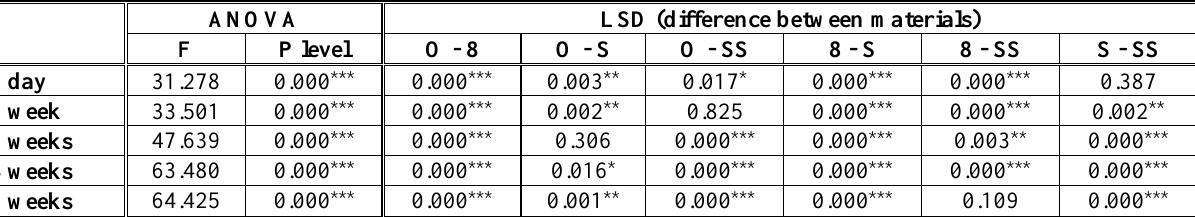
Table 2: Difference between the distance moved according to the ligation method at the five time intervals by ANOVA and LSD tests.